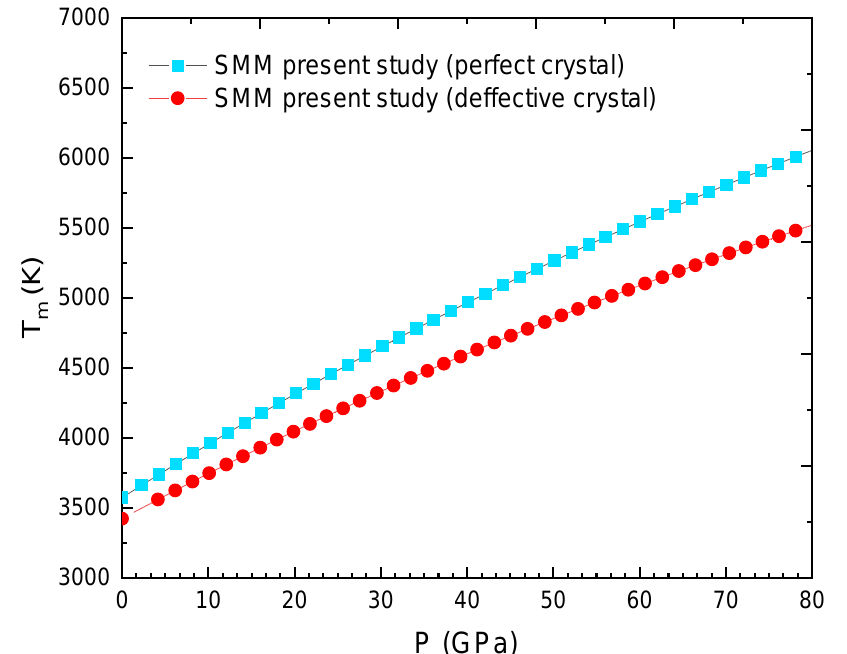
Figure 8. T m ( P ) for WSi at c Si = 1% obtained from the SMM for the perfect model and the SMM for the defective model [3]. Table 8. Si concentration and pressure dependence of volume jumping WSi at T = 300 K .